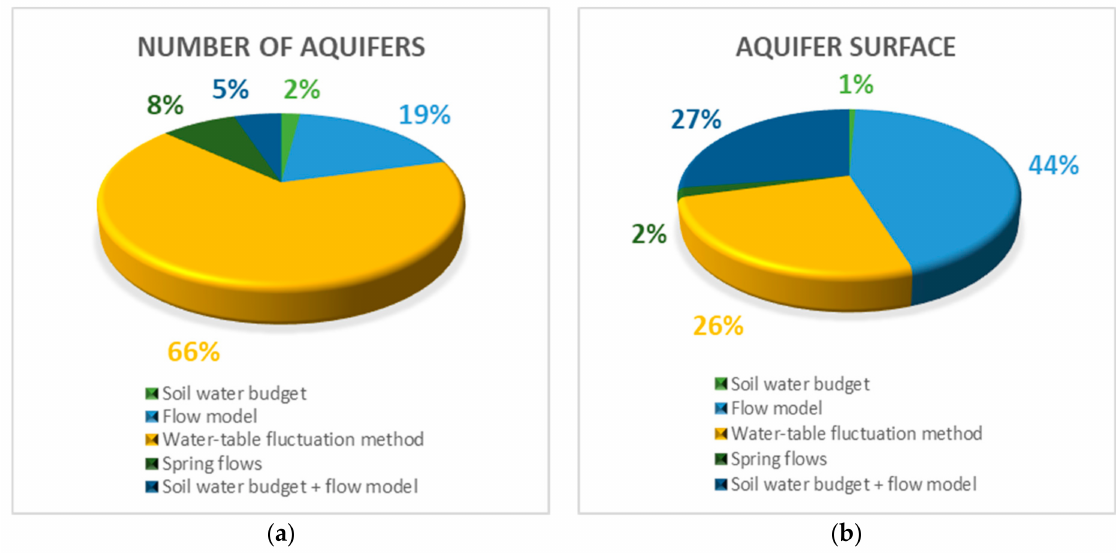
Figure 13. Methodologies used for the estimation of recharge by number of aquifers ( a ) and aquifer surface ( b